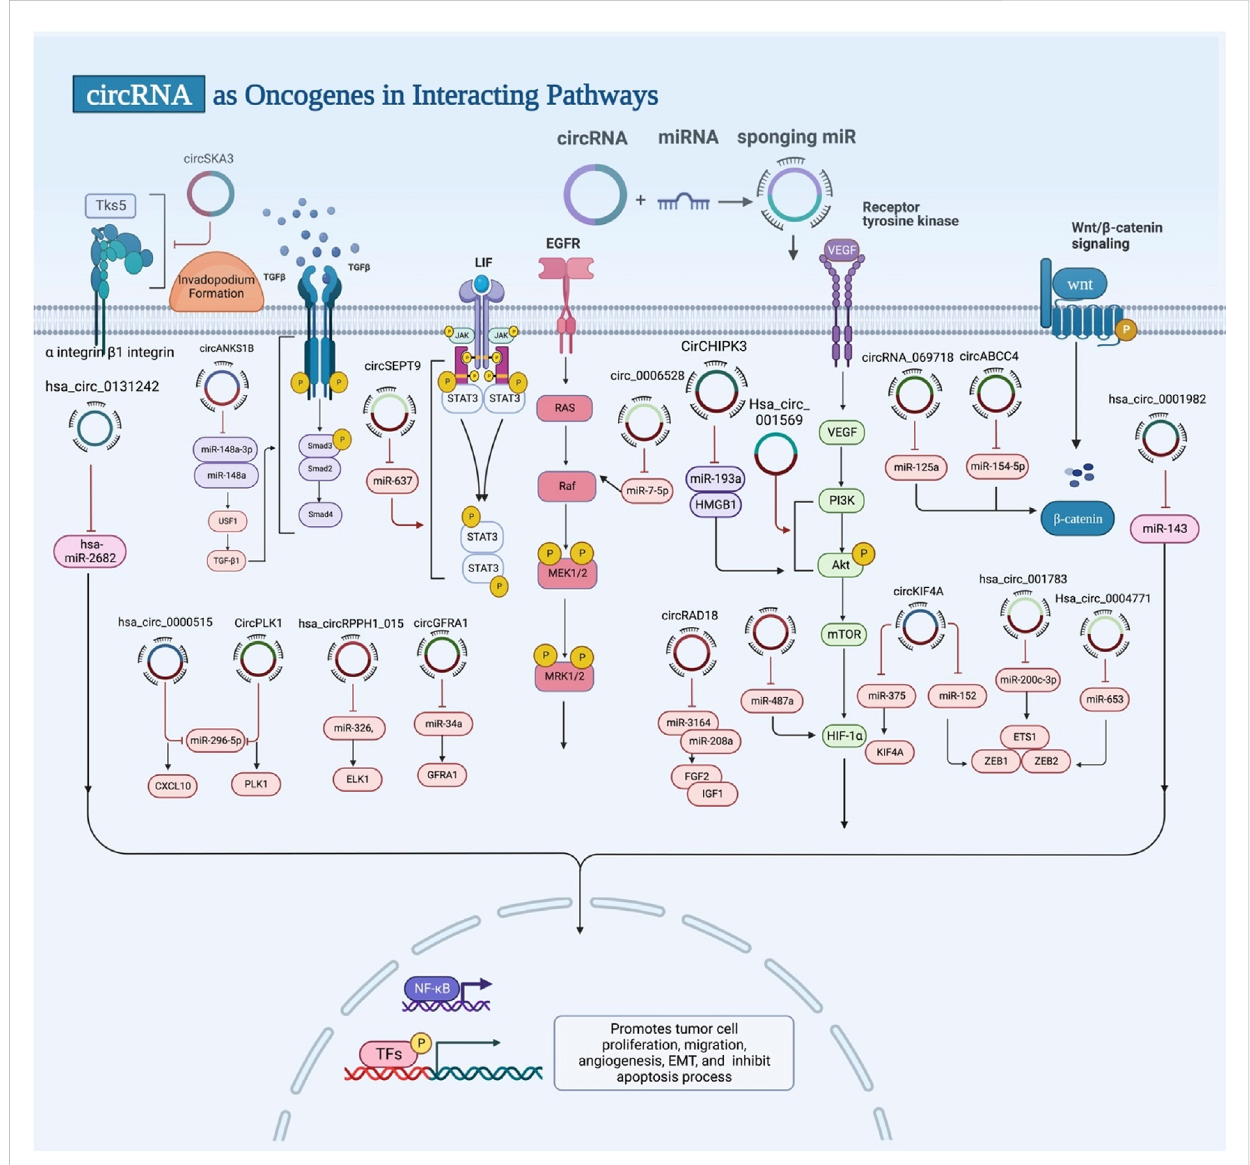
FIGURE 3 Exosomal circRNAs act asoncogenes.ExosomalcircRNAscan promotetumorcell proliferation,migration,angiogenesis,EMTand inhibitapoptosis by targeting miRNA, genes, and signalling